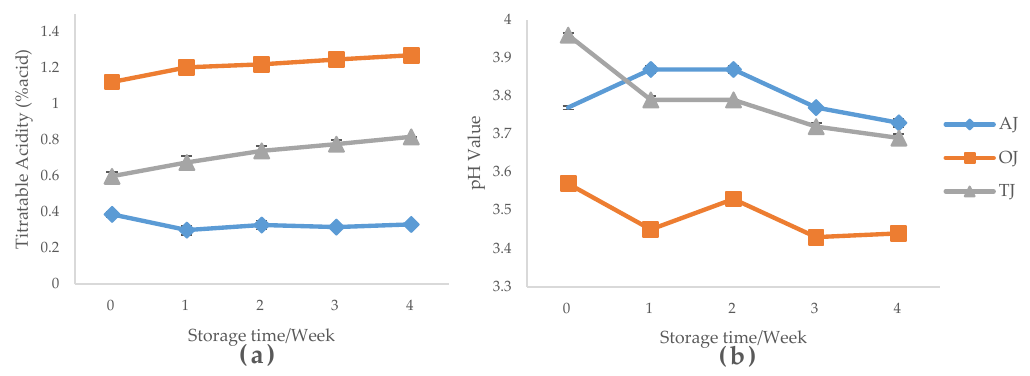
Figure 1. The pH and titratable acidity of probiotic-fortified apple, orange and tomato juices during 4 weeks of storage under 4 ◦ C. ( a ) titratable acidity changes; ( b ) pH value changes. AJ, probiotic-fortified apple juice; OJ, probiotic-fortified orange juice; TJ, probiotic-fortified tomato juice.